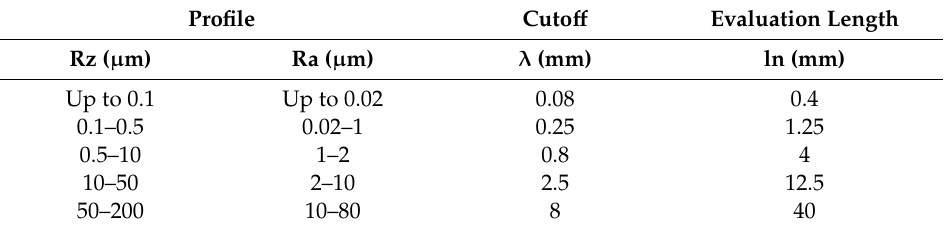
Table 4. Recommended cut-o ff and evaluation length according to the UNI EN ISO 4288:2000